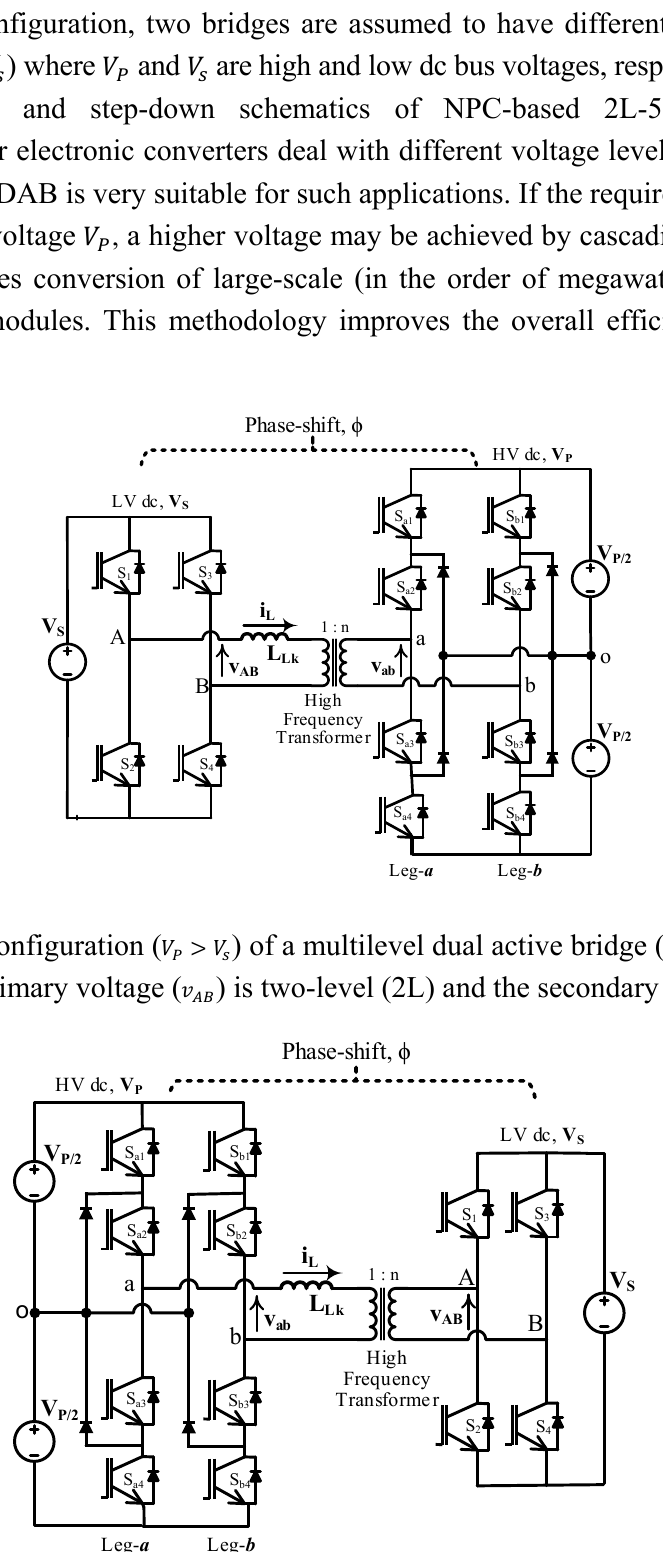
Figure 2. Buck configuration ( (cid:1848) voltage ( (cid:1874) ) is of 5L and the secondary ( (cid:1874) (cid:3028)(cid:3029)